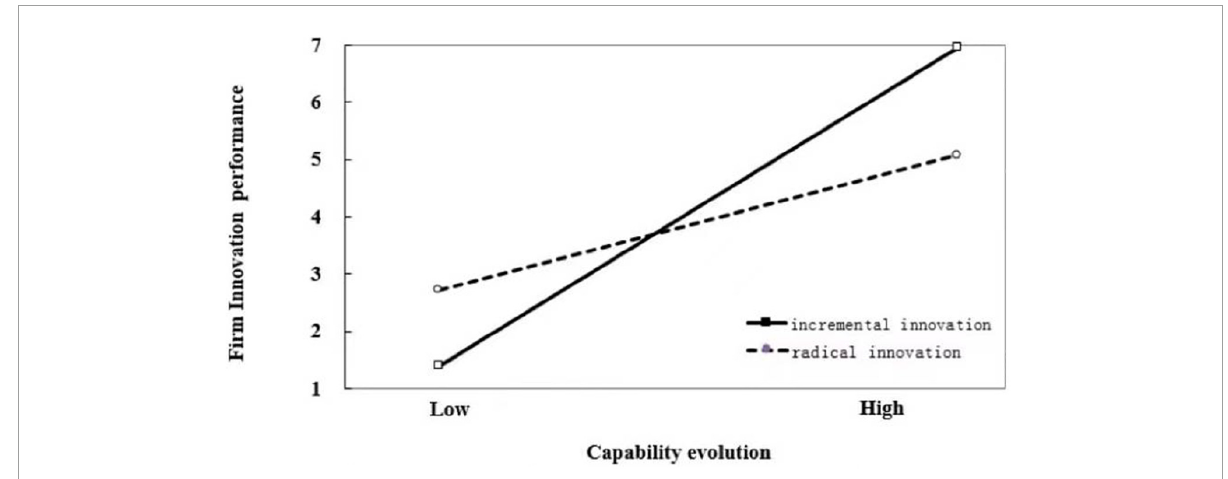
FIGURE1 Moderating effect of innovation magnitude on the relationship between capability evolution and firm innovation performance in the early stage of catch-up.